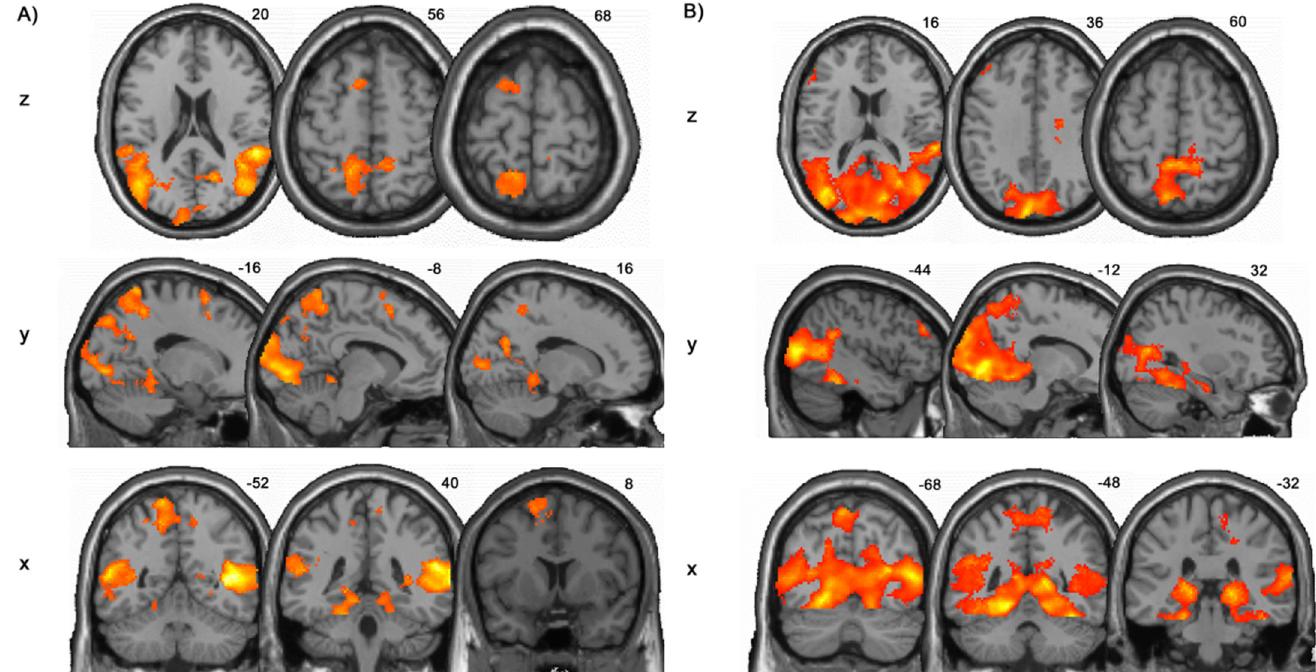
Fig 3. Pooled ( “ Activities ” and “ Walking ” together) task-related activity per group. A) Healthy controls (HC) and B) chronic Low Back Pain (LBP) patients (q < 0.05, false discovery rate corrected,